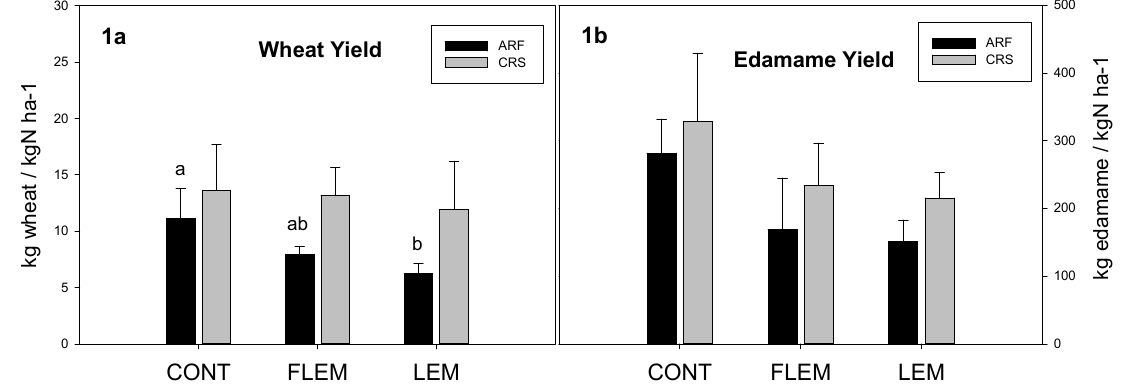
Figure 1. Amount of crop per kg N in the soil after treatment application: wheat (winter, 2017) and edamame soybean (summer, 2017) harvested from plots managed previously under an annual ryegrass / fallow rotation (ARF) and under a cereal rye / edamame soybean rotation (CRS). Di ff erent letters indicate di ff erences between inoculant treatments. No letters indicate no significant di ff erences between treatments; α = 0.1.